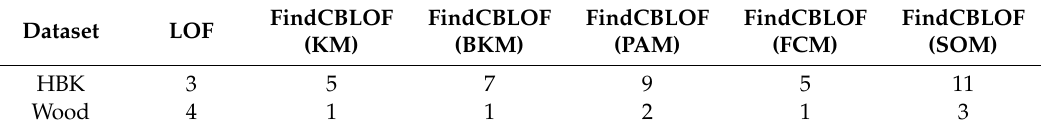
Table 4. The number of true detected outliers (LOF and FindCBLOF).